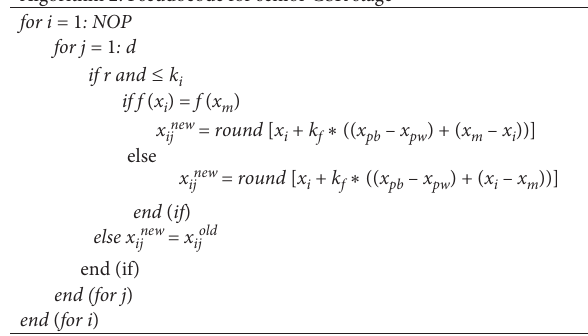
Figure 3: Pseudocode for the junior GSK stage.